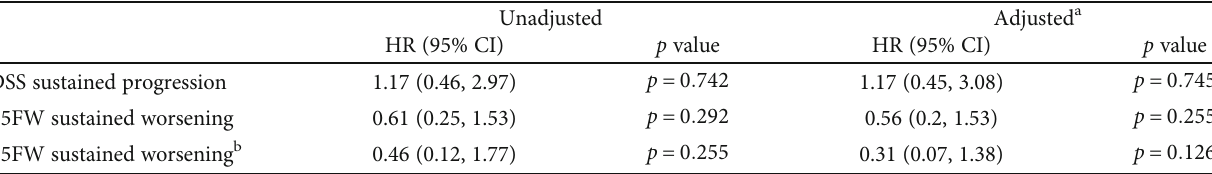
Table 3: Hazard ratio, 95% con fi dence intervals, and p value for EDSS and T25FW worsening comparing teri fl unomide and glatiramer acetate-treated